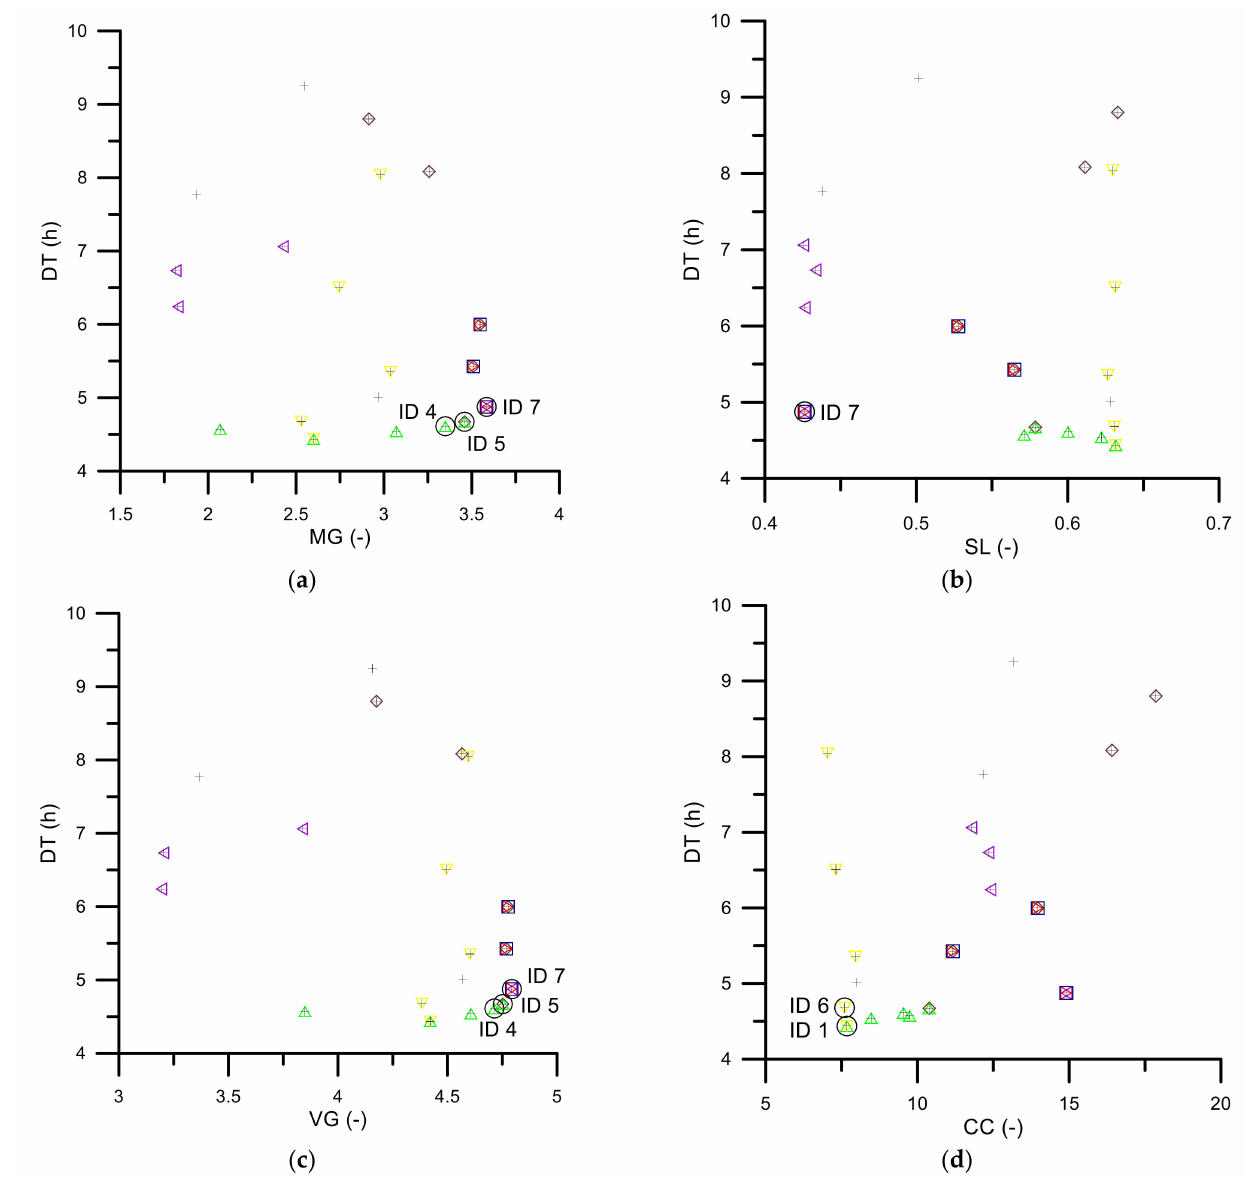
Figure 3. Pareto fronts: ( a ) DT-MG, ( b ) DT-SL, ( c ) DT-VG, ( d ) DT-CC; +—data, O—the best solutions, —EC min , —MG max , —DT min , —CC min , —VG max -, —SL min